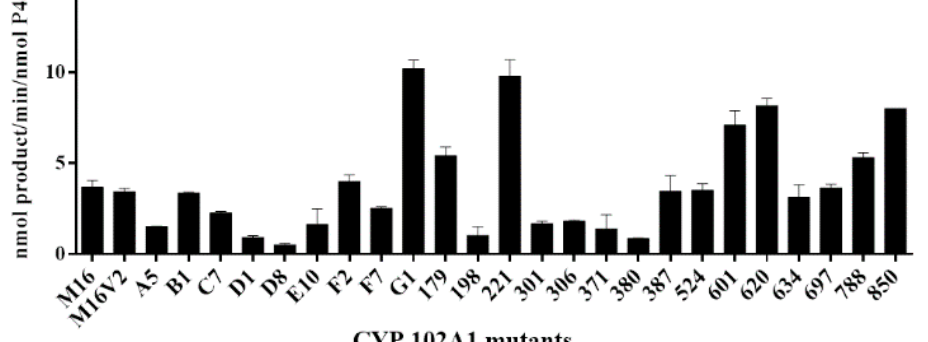
Figure 2. Catalytic activity of naringin DC hydroxylation by CYP102A1 mutants. The reactions contained 200 µM naringin DC as a substrate in 100 mM potassium phosphate buffer (pH 7.4) and 0.20 µM CYP102A1. NADPH-generating systems were added to initiate the reaction, and the reaction mixtures were incubated for 30 min at 37 °C.